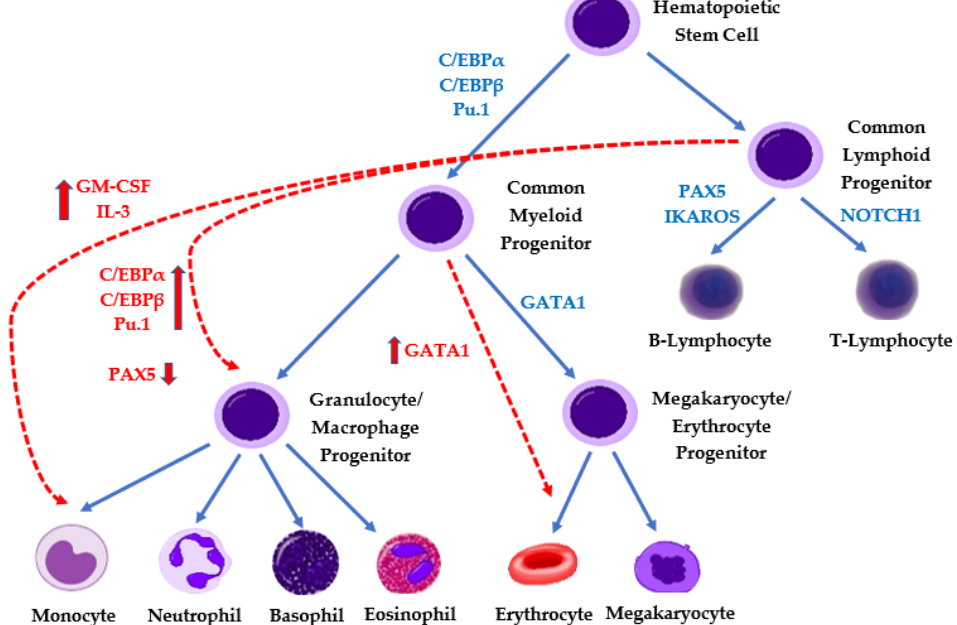
Figure 1. Regulation of lineage commitment in hematopoiesis. Solid lines/blue text indicate regula- tors of normal hematopoiesis, and red lines (—) and text highlight aberrant regulation implicated in MPAL pathogenesis.